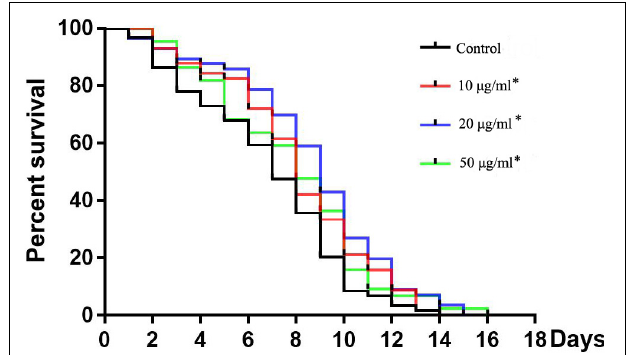
FIGURE 2 | Effects of TFH on lifespan of C. elegans . Three replicates were used per treatment. Differences in survival curves between treatment and control groups were found in all TFH treated groups. Differences compared to control group were considered significant at * p ≤